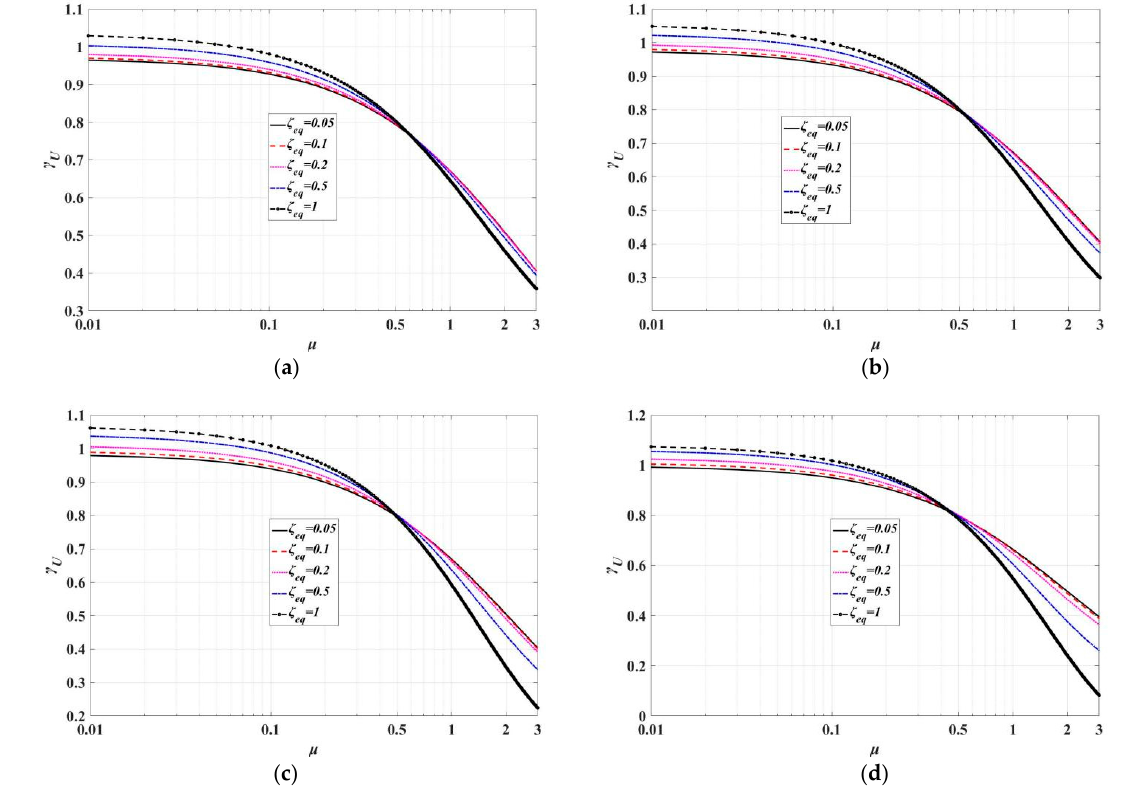
Figure 4. Curves of γ U under different damping ratio ζ eq ( κ = 0.1, ζ b = 0.02): ( a ) HB–1 ; ( b ) HB–2 ; ( c ) LB–1 ; ( d ) LB–2